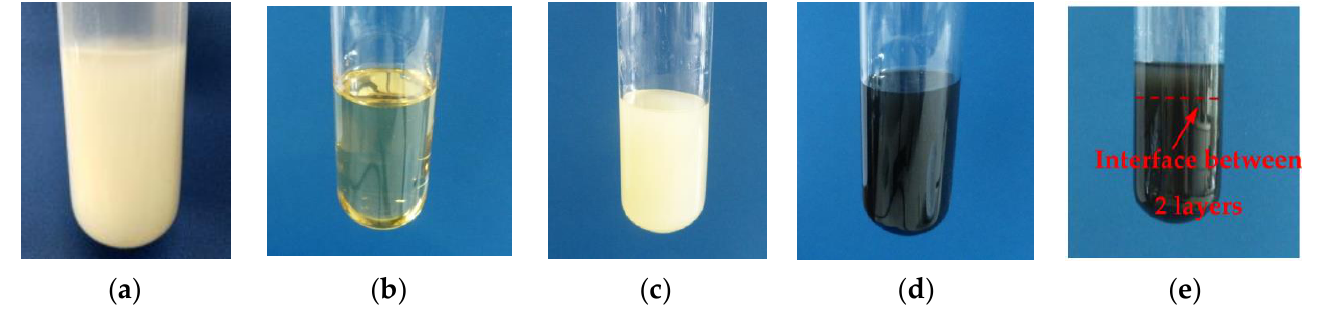
Figure 3. Images of 15 wt.% PPSU-15 wt.%PEG 20,000 systems in NMP at T = 20 °C ( a ) and T = 40 °C ( b ) with different additives: ( c )—0.5 wt.% PVP K-30 at T = 40 °C; ( d )—0.5 wt.% PVP K-30, 0.5 wt.% O-MWCNTs at T = 40 °C; ( e )—0.5 wt.% PVP K-30, 0.5 wt.% O-MWCNTs at T = 130 °C.